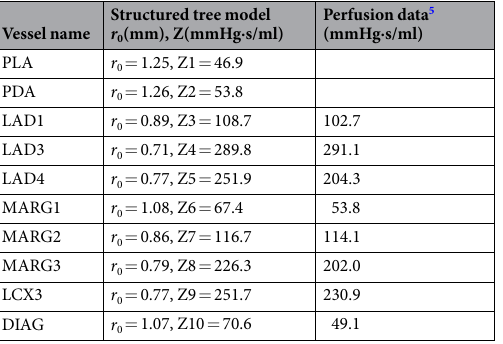
Table 3. Comparison of the terminal impedance estimated from the structured tree model (8) and published perfusion data. No published data are found for Z1 and Z2.